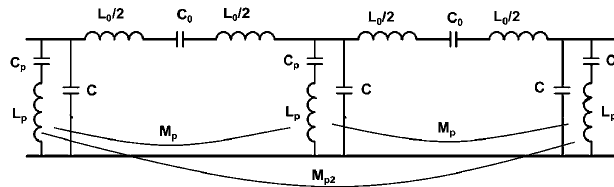
FIG. 20. Equivalent circuit including nearest and next nearest coupling between PCs.